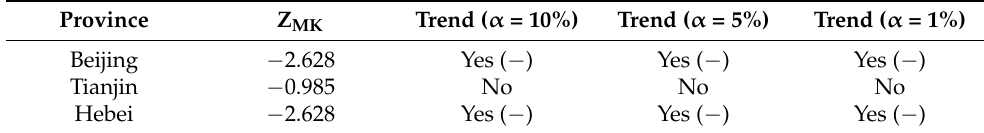
Figure 6. Grey water footprint (GWF) and per capita GWF of the BTH region. Table 4. Mann – Kendall test results for grey water footprint (GWF) during 2004 – 2017.